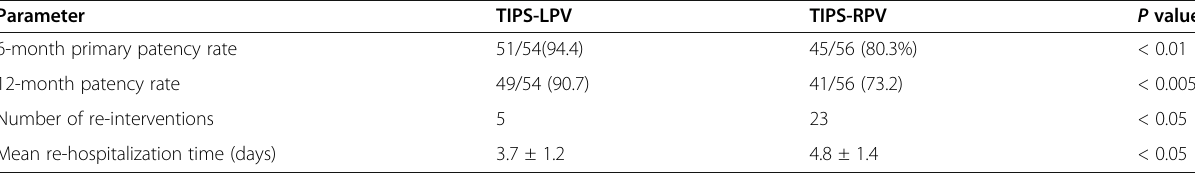
Table 2 Follow up 6 month after TIPS in both studied groups Parameter